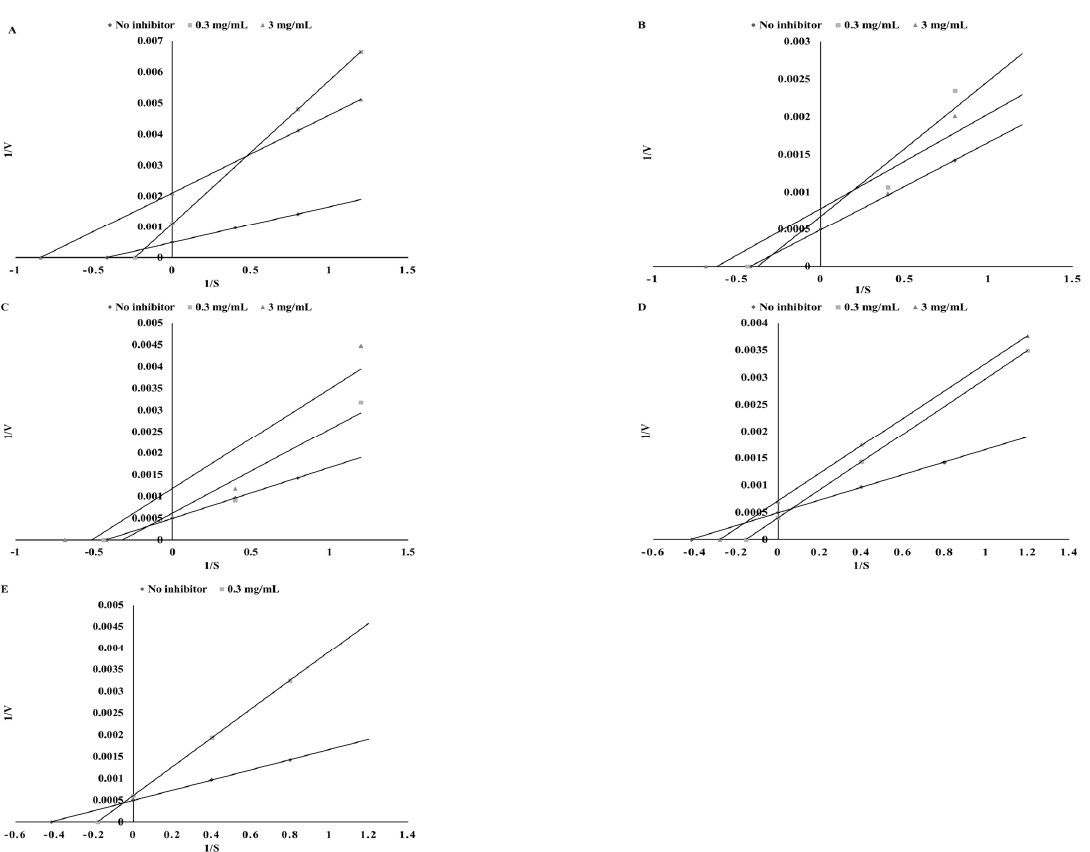
Table 5. IC 50 value, Ki value, Vmax value, and mode of LOX inhibition by ethanol and digested extracts from parsley, cumin, green tea, green coffee, and mustard ( n = 9).